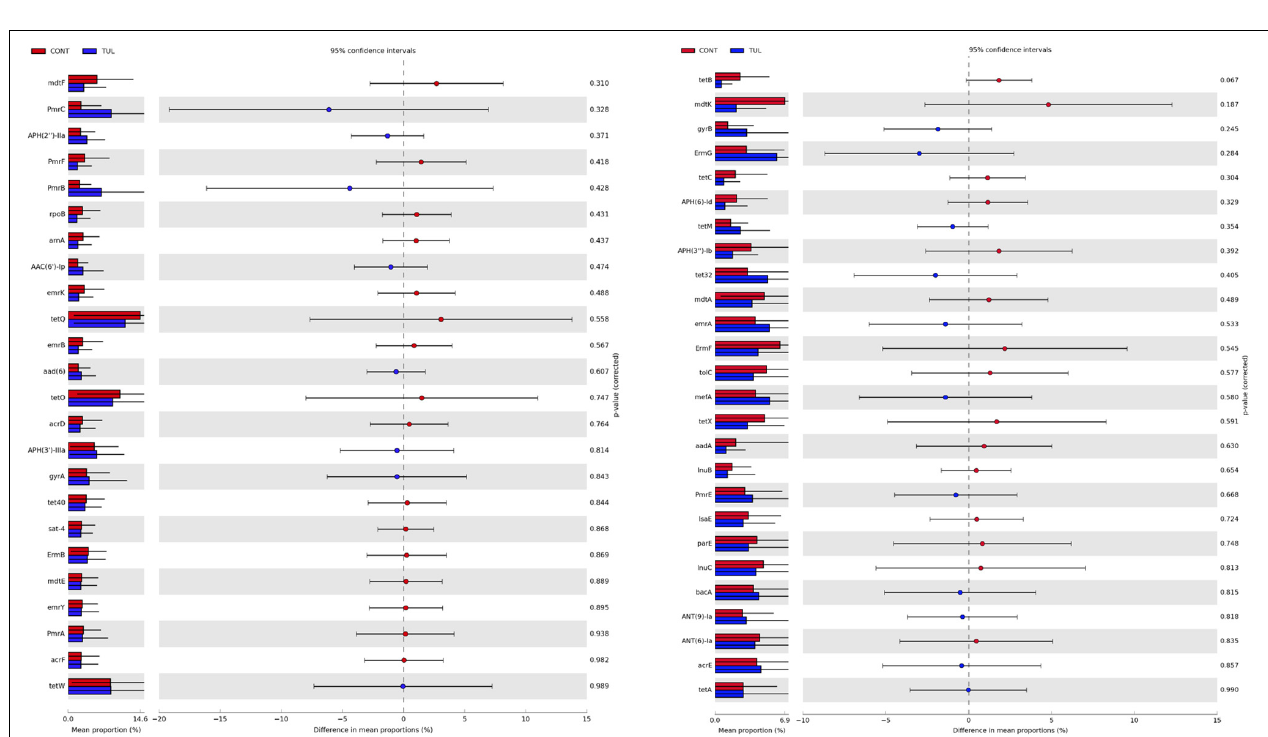
FIGURE 7 | Extended bar plot showed the 50-predominant antimicrobial resistance genes, between the control (CONT) and tulathromycin (TUL) groups. P -value < 0.05 was considered significant.